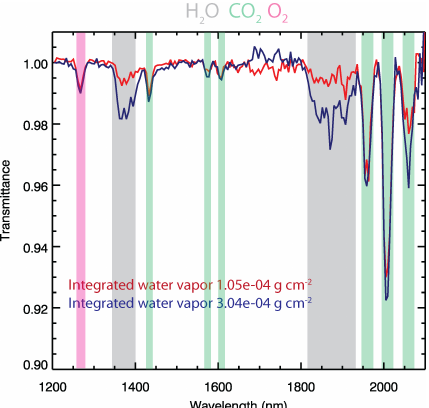
Figure 4. Transmittance spectra from the profiles shown in Fig. 2. Absorption band positions and widths are color coded: water vapor in gray, O 2 in magenta, and CO 2 in green. Integrated water vapor amounts in the figure indicate the corresponding water vapor col- umn determined from the in situ